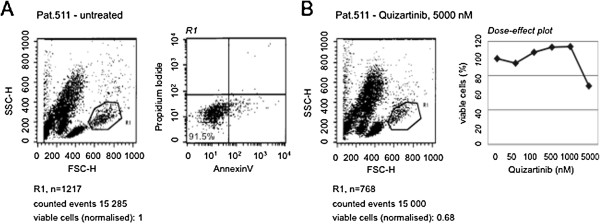
Quizartinib reduces the proportion of viable cells in samples of native leukemia cells. Patient samples were cultured in DMEM containing 20% FBS and treated with different concentrations of quizartinib for 48 hours. (A) The plot of one patient is shown. The mononuclear cell fraction was gated in a FSC/SSC scatter and viability was confirmed using an annexin V/propidium iodide (PI) stain demonstrating negativity for annexin V and PI. (B) Relative reduction of the proportion of viable cells in response to quizartinib was assessed by flow cytometry. A dose-effect plot of all tested concentrations of quizartinib is shown on the right. Estimated IC50s by non-linear regression analysis of all tested patient samples are provided in Table 2.